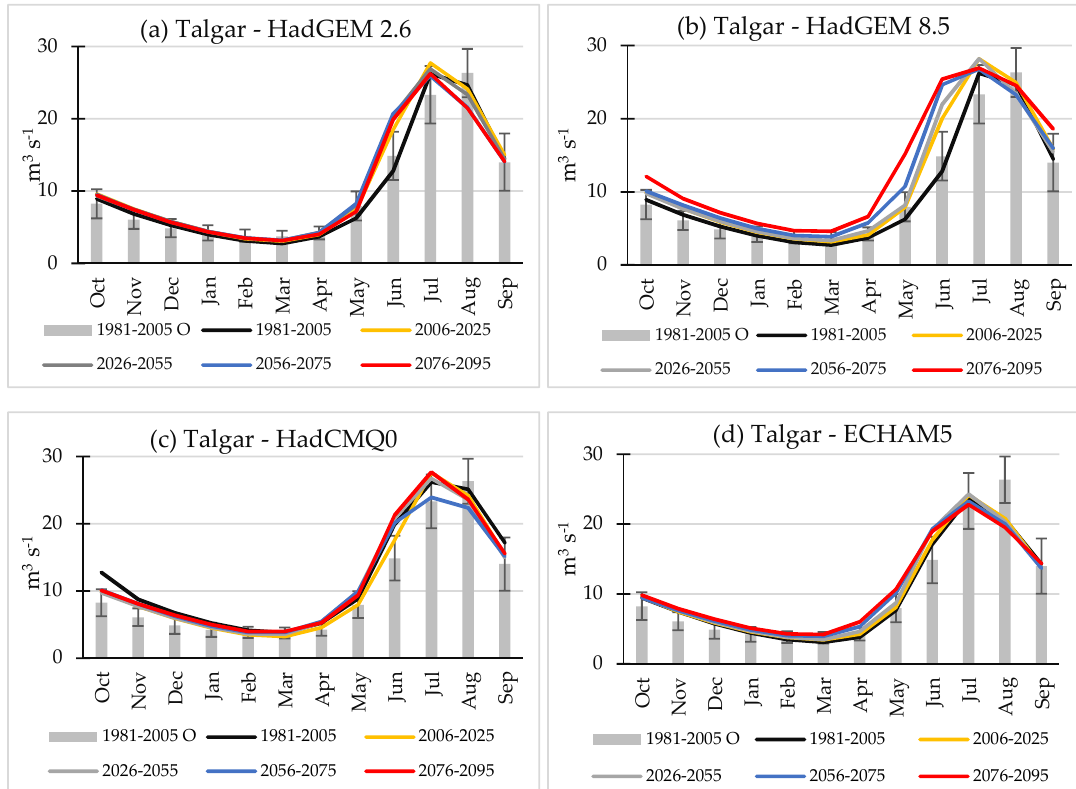
Figure 13. As in Figure 12 but for the Kishi Almaty.